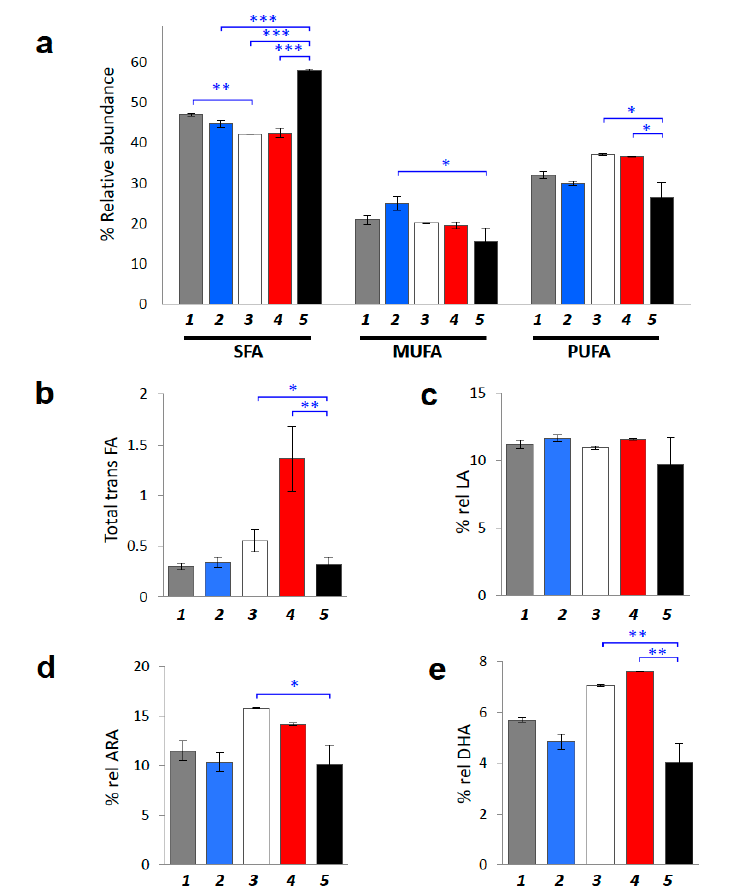
Figure 4. Fatty-acid based membrane lipidomic analysis. ( a ) Fatty acid composition grouped into families SFA, MUFA and PUFA of erythrocyte membrane at early and late stages of control SCID and tumor-bearing mice; comparison among control (4-weeks and 17-weeks old; Group 1 and Group 2 , respectively) and diseased mice (4-weeks old, 5-weeks old and 17-weeks old; Group 3 , Group 4 and Group 5 , respectively). ( b ) Total trans fatty acids isomers of erythrocyte membrane among control SCID ( Group 1 and Group 2 ) and tumor-bearing mice ( Group 3, Group 4 and Group 5 ). ( c ) LA (18:2 ω -6) levels for the five distinct mice groups. ( d ) ARA (20:4 ω -6) levels for the five distinct mice groups. ( e ) DHA (22:6 ω -3) levels for the five distinct mice groups. Values represent mean ± SD ( n = 3). * ( p < 0.05), ** ( p < 0.01), *** ( p < 0.001).